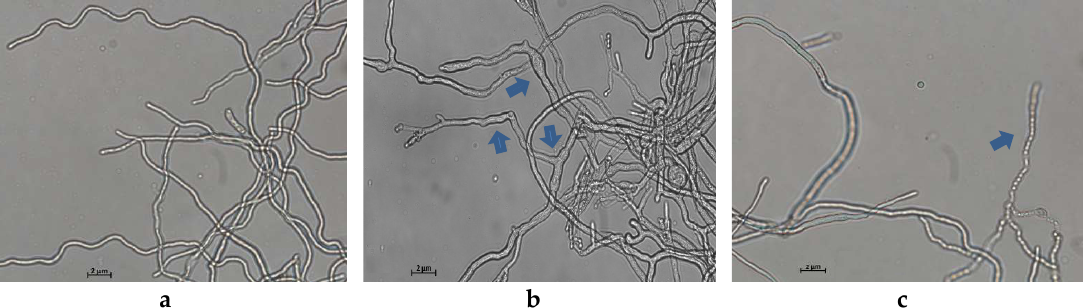
Figure 3. Light microscopy observation of P. italicum mycelial morphology (96 h). ( a ) P. italicum in the control group, ( b ) and ( c ) P. italicum in the treatment group (magnification is 400 times).